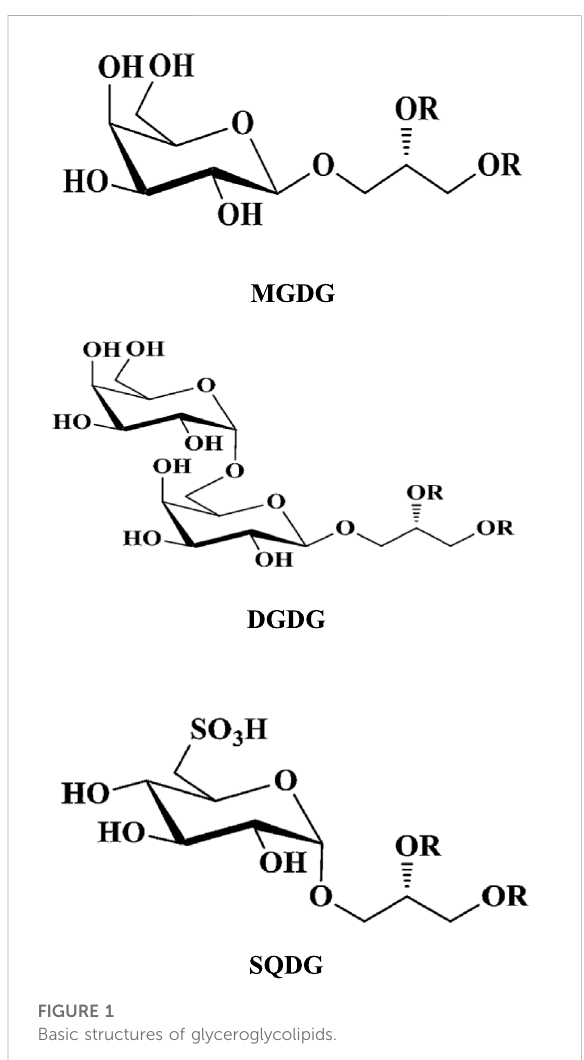
FIGURE 1 Basic structures of